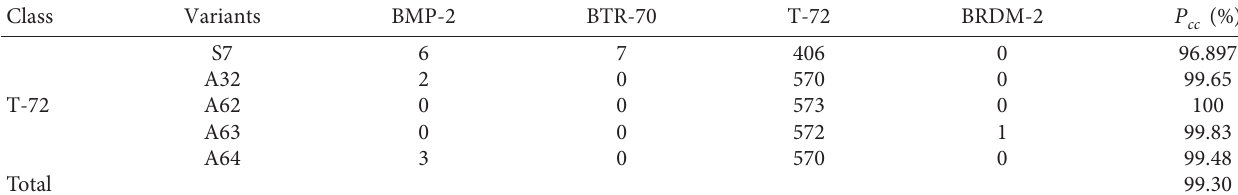
Table 7: Confusion matrix of Enhanced-shape CNN under EOC-1 (configuration variants).